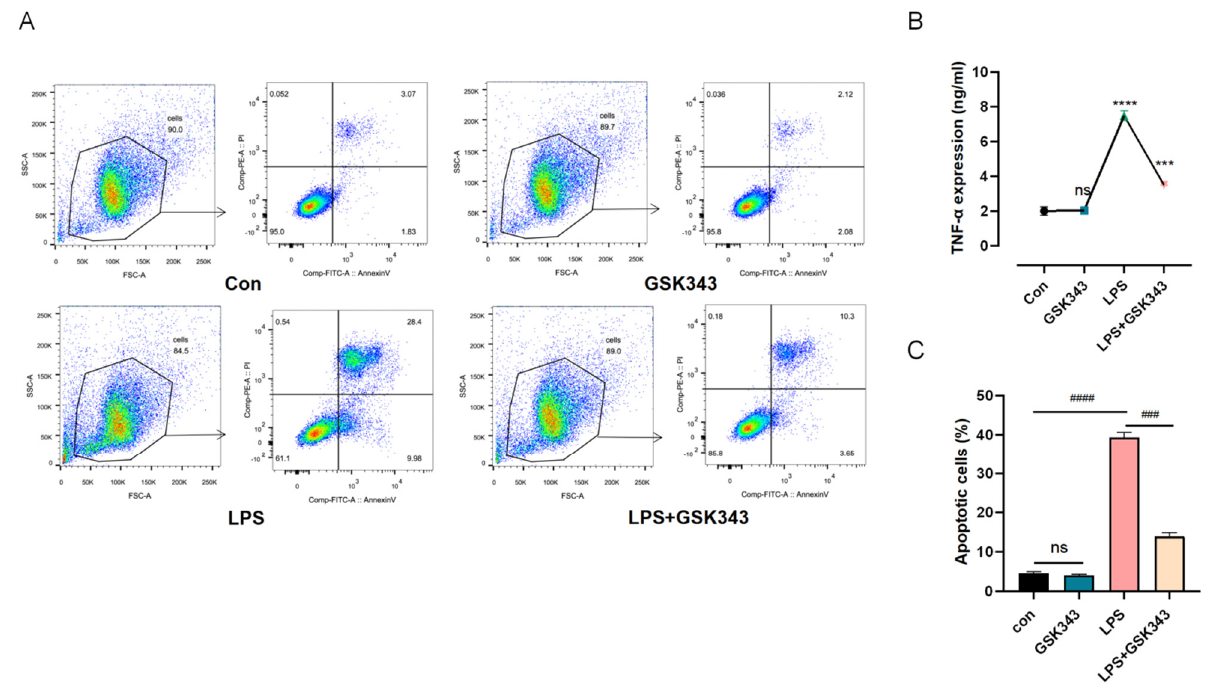
Figure 6. GSK343 alleviated LPS-induced ATII apoptosis. ( A , C ) Flow cytometry was employed to detect the apoptosis rate of ATIIs. The cells were equally divided into the Con group, LPS group, GSK343 group, and LPS + GSK343 group. We evaluated the proportion of apoptotic cells (Q2 + Q3) in each group. ( B ) The effect of GSK343 on the expression of TNF- α in LPS-induced PBMCs. Data are presented as mean ± SD ( n = 3 per group) of the representative data from three independent experiments; *** p < 0.005, **** p < 0.001, ns: no significance, ### p < 0.005, #### p < 0.001. The asterisk (*) shows that the group is statistically different from the Con group.